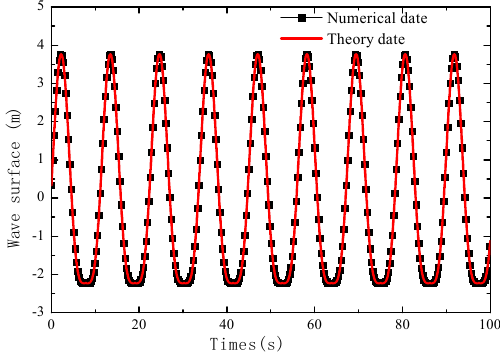
Figure 6. Validations of the maximum uplift force ( F v ma x ) for various mesh systems.